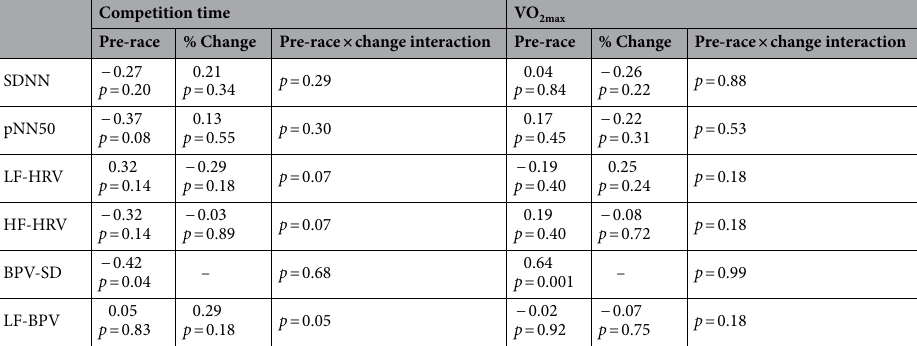
Table 5. Correlations between the parameters of individual performance (the competition time and VO 2max ) and the HRV and BPV parameters (pre-race values and pre-vs. post-race changes). r Pearson’s linear correlation coefficients and p values are presented for correlations with pre-race values and % change; p values for general linear model are presented for pre-race × change interaction. SDNN, standard deviation of RRIs; pNN50, the percentage of adjacent RRIs with a difference of duration > 50 ms; LF-HRV, the power of HRV spectrum within low-frequency range; HF-HRV, the power of HRV spectrum within high-frequency range; BPV-SD, standard deviation of beat-to-beat SBP; LF-BPV, the power of DBP variability spectrum within low- frequency range.